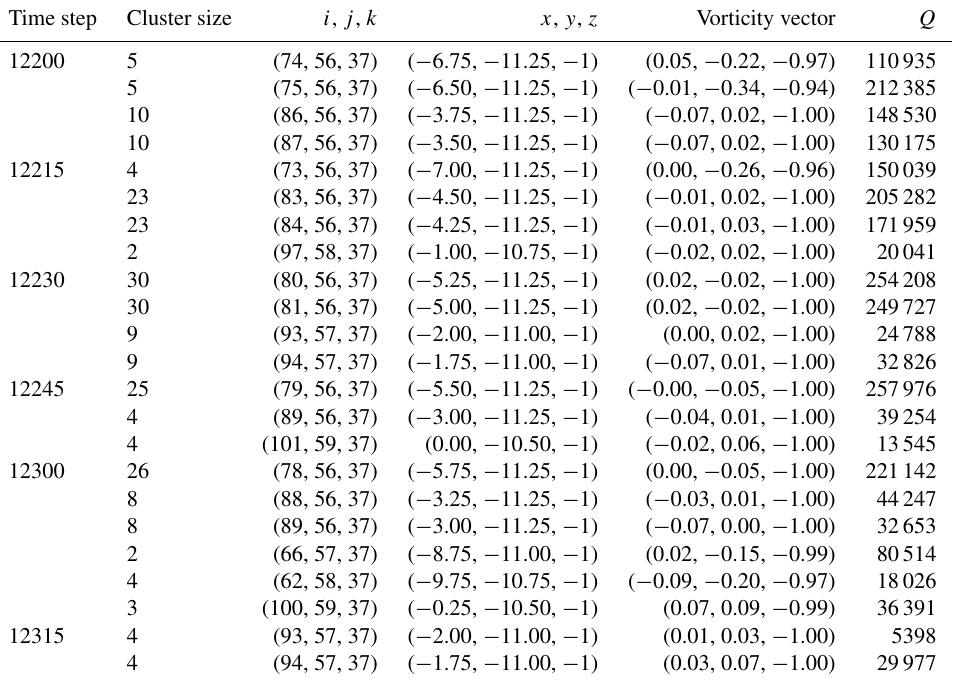
Table 1. Properties of the vortices found with our algorithm separated into time step, cluster size, transformed coordinate system, vortex coordinates, vorticity vector and Q